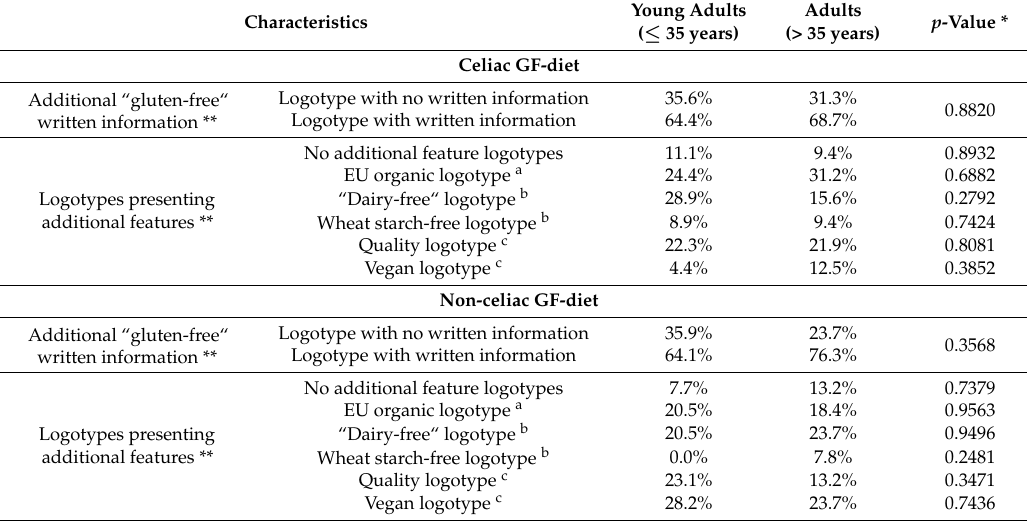
Table 6. The comparison of the front-of-package “gluten-free” (GF) product labeled attributes influencing the choice of GF bread in subgroups of celiac GF-diet and non-celiac GF-diet participants stratified by